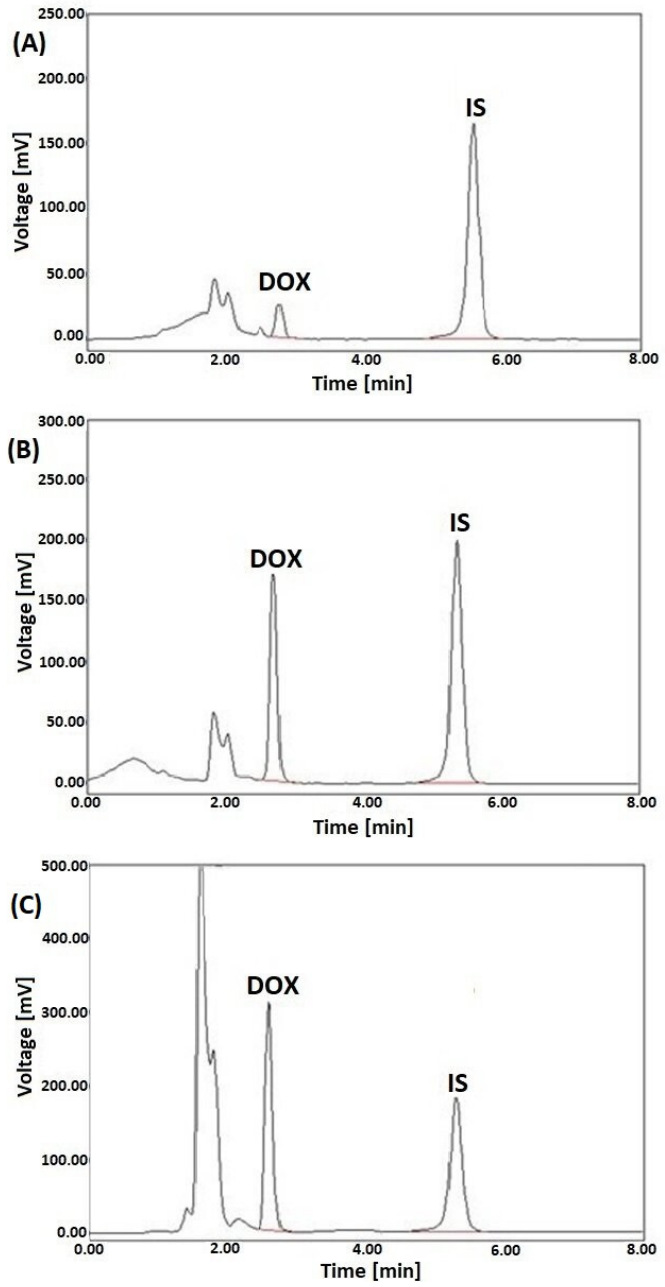
Figure 3. Representative LC-FL chromatograms of rat extracts of spleen ( A ), kidney ( B ), and heart ( C ) spiked with DOX at the 2, 10, and 20 µg/g, respectively, and DAU (IS) at a concentration of 10 µg/g, after SPE with HLB columns.